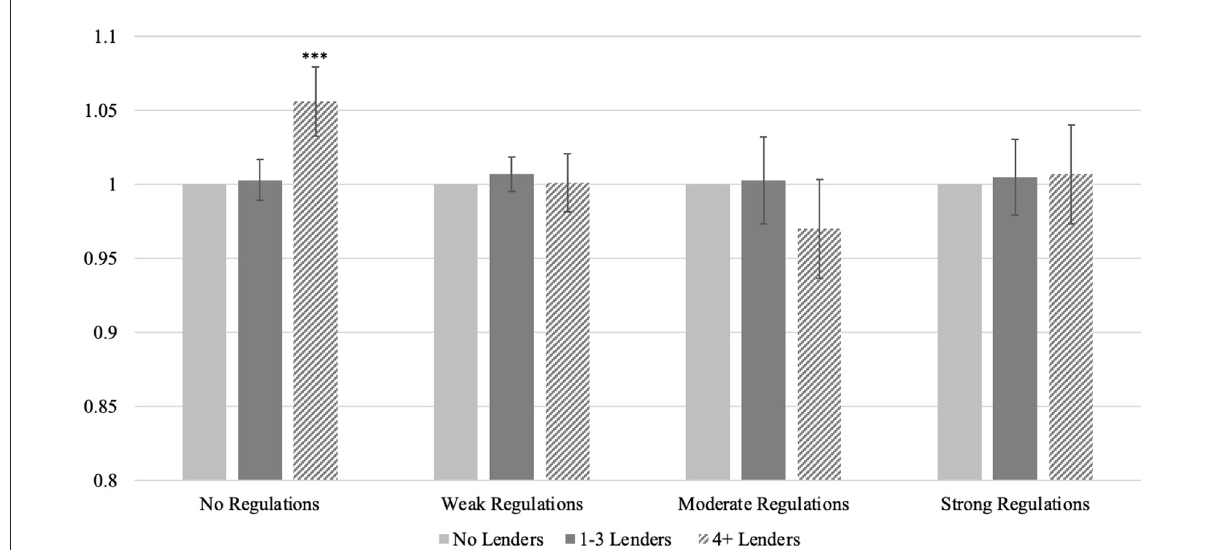
FIGURE3 Within-regulatory group relative risks for premature deaths. Within-period incidence risk ratios relative to counties with no lenders (left-most column in each group); error bars reflect 95% confidence intervals. *** p < 0.001, compared to counties with no lenders. Exposure term is population ages 20–59; 2,626 counties contributed 42,230 observations. Derived from Model 2 in Appendix C using Stata margins and nlcom